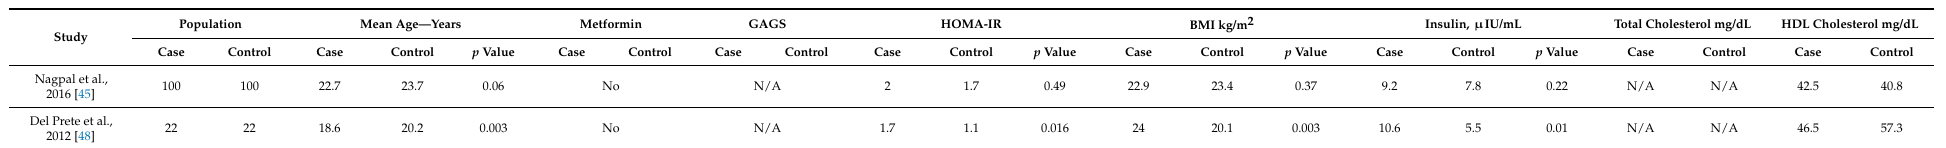
Table 3. Studies evaluating the correlation between insulin resistance and acne in male patients. (GAGS: Global Acne Grading System, HOMA-IR: homeostasis model assessment-insulin